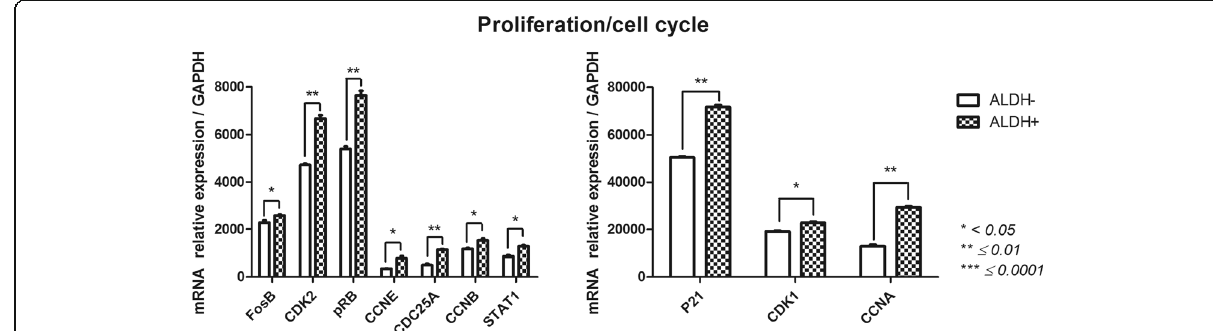
Fig. 4 Cell-cycle-related gene expression profile of FSK-MSC subsets according to ALDH activity. After flow cytometry sorting of ALDH+ and ALDH- FSK-MSC subsets, we investigated by qPCR the expression profiles of cell-cycle-associated genes FosB, CDK2, pRB, CCNE, CDC25A, CCNA, CCNB, STAT1, P21 and CDK1 . Data are presented as mean ± SEM of mRNA gene expression relative to GAPDH expression